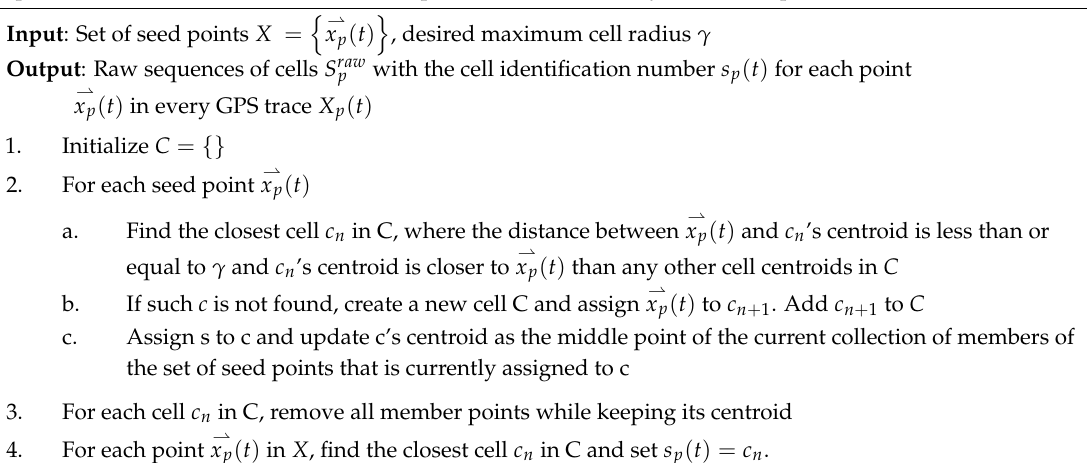
Algorithm 1 : Description of the data-driven space segmentation algorithm presented by [13], which segments space into a set of cells and derives the sequence of cells visited by each of the pedestrians at the